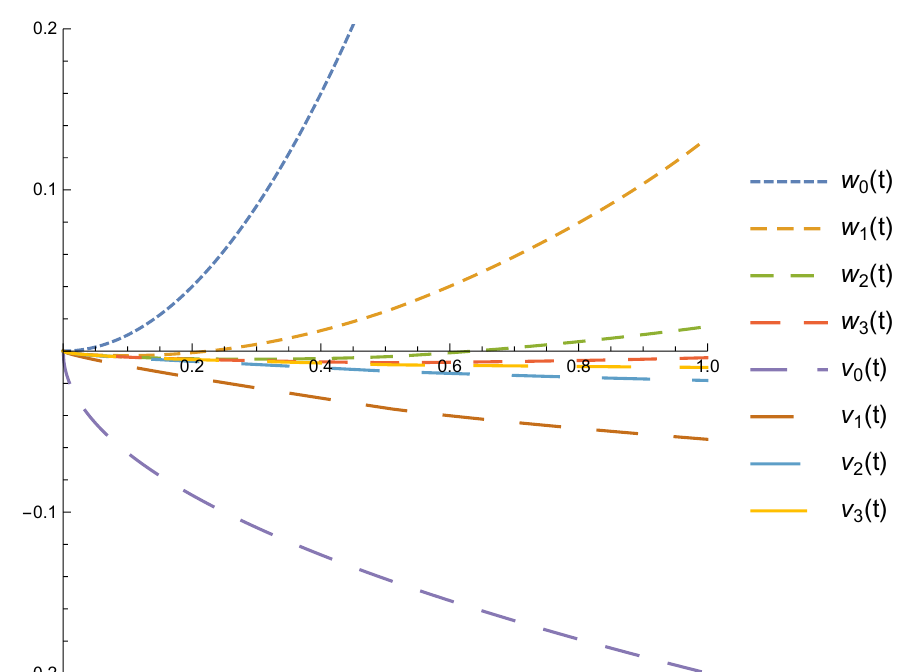
Figure 3. Graphs of the upper/lpwer successive approximations v ( n ) ( t ) and w ( n ) ( t ) , n = 0, 1, 2, 3, on the interval [ 0,1 ] .